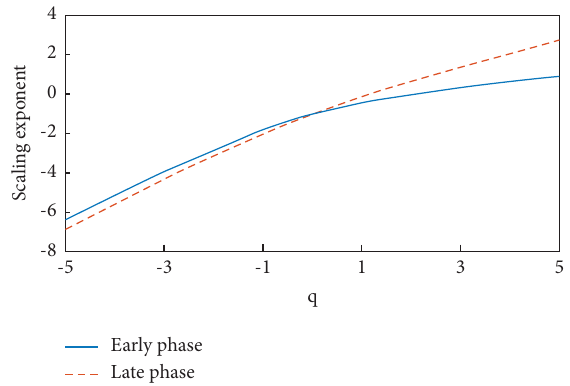
Figure 15: Early and late scaling exponent.